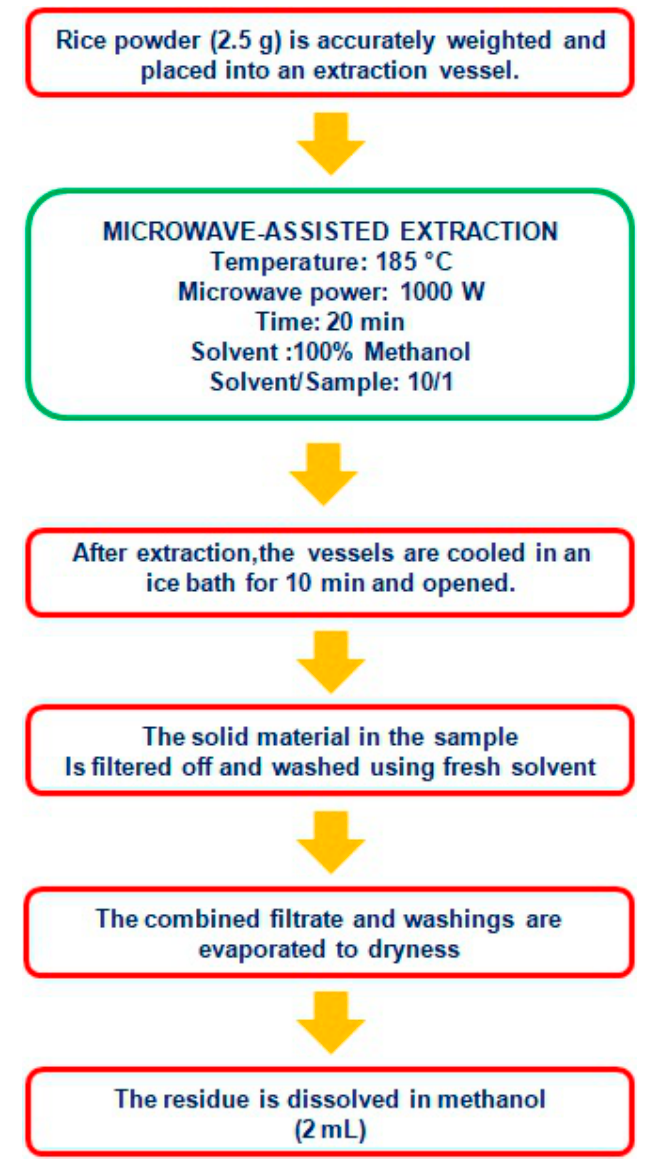
Figure 5. Microwave assisted extraction (MAE) of phenolic compounds from rice as described by Setyaningsih et al. (2015) [34].